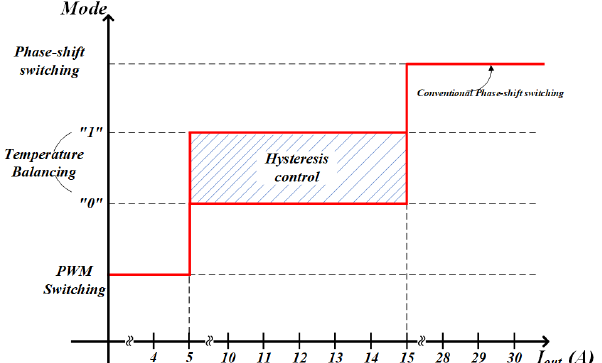
Figure 7. Transition points in the proposed switching method.